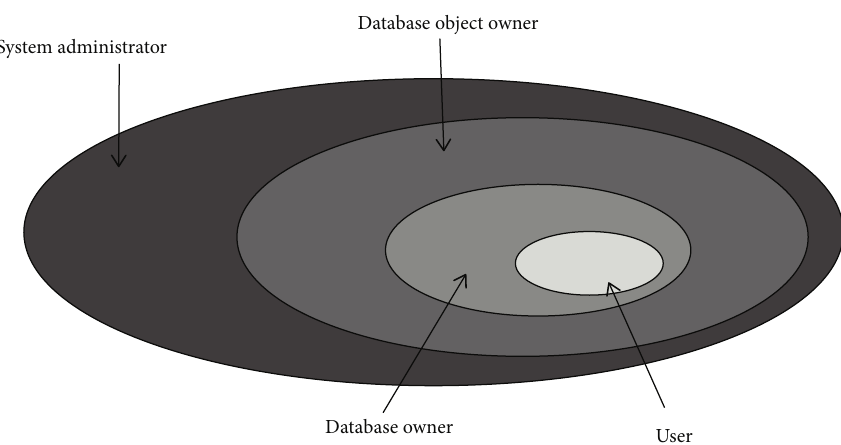
Figure 2: : Permission level of the SQL